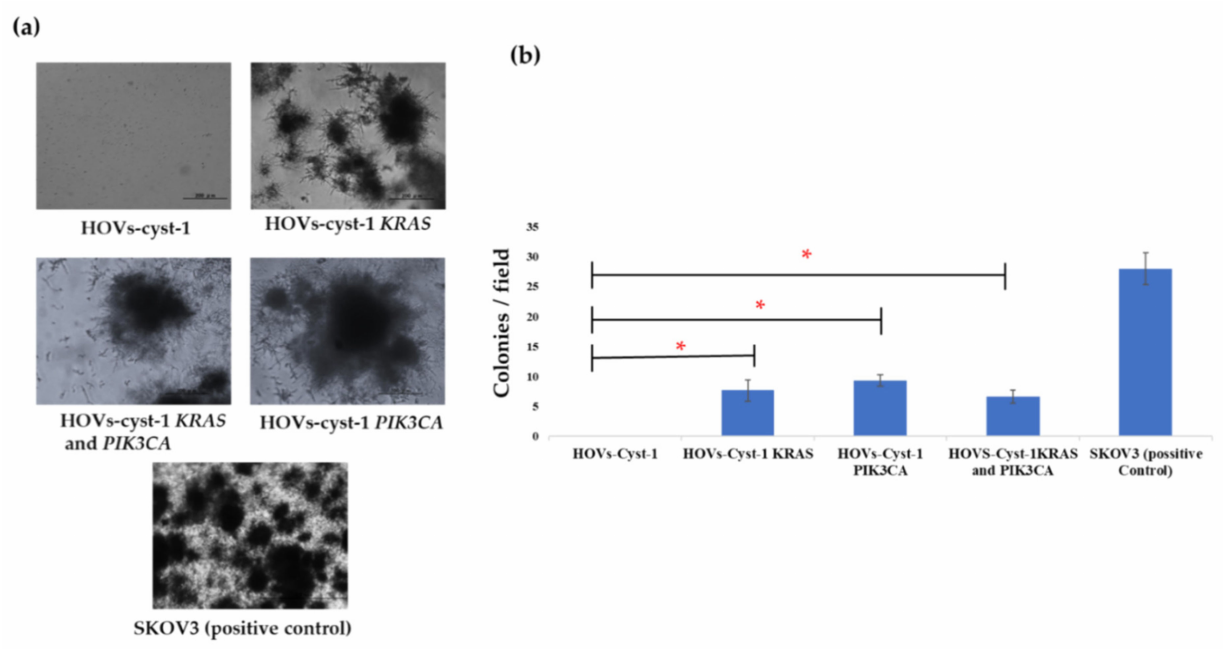
Figure 4. Anchorage-independent growth assay. ( a ) Cell colonies in Matrigel. The HOVs-cyst-1 cells, with different mutations, showed colonies in Matrigel; SKOV3 cells were used as positive control. ( b ) All mutant cells (HOVs-cyst-1 KRAS , HOVs-cyst-1 PIK3CA , and HOVs-cyst-1 KRAS + PIK3CA ) formed colonies, and the number of colonies did not differ significantly (* p <